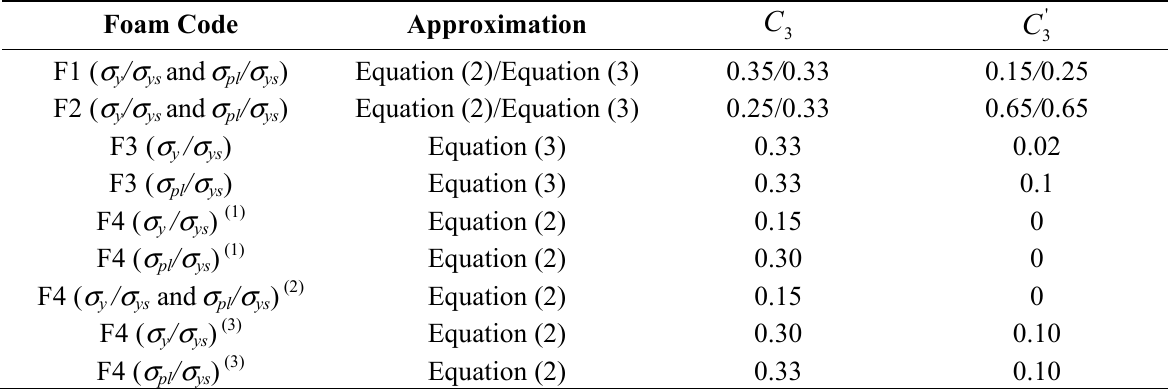
Table 4. Scaling lows for approximation of the compressive strength for